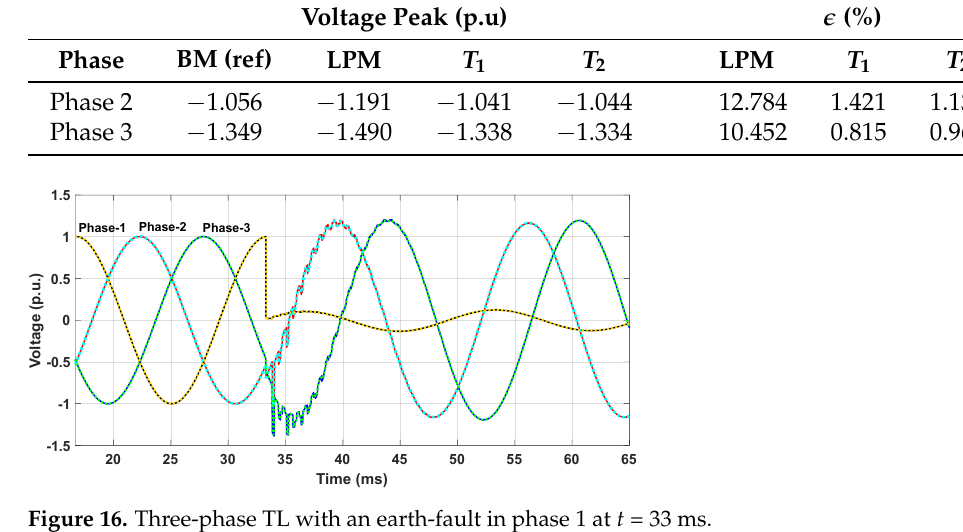
Figure 16. Three-phase TL with an earth-fault in phase 1 at t = 33 ms.